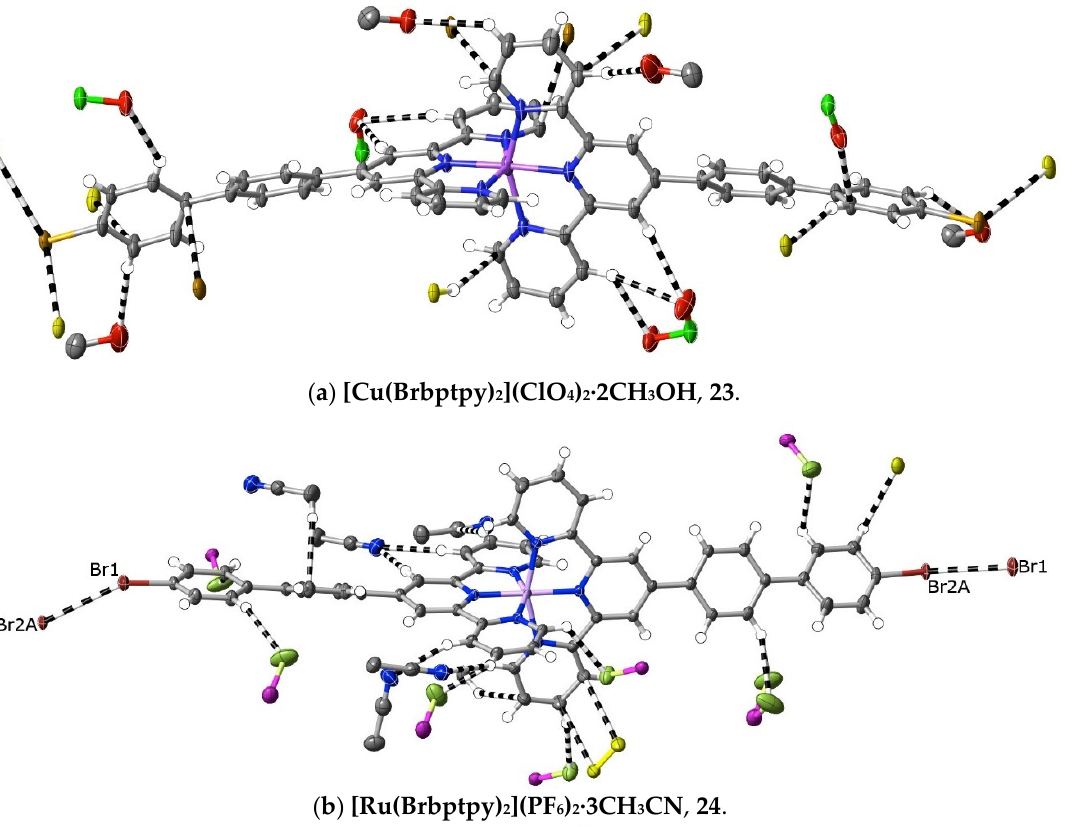
Figure 7. Interactions exceeding dispersion in complexes of pybptpy, showing, ( a ) in the Ni(II) complex as an example, a partial view of the stacking, which appears to be reinforced by N ... HC interactions, and ( b – c ) the full range of cation in- teractions in the Ni(II) and Zn(II) complexes.